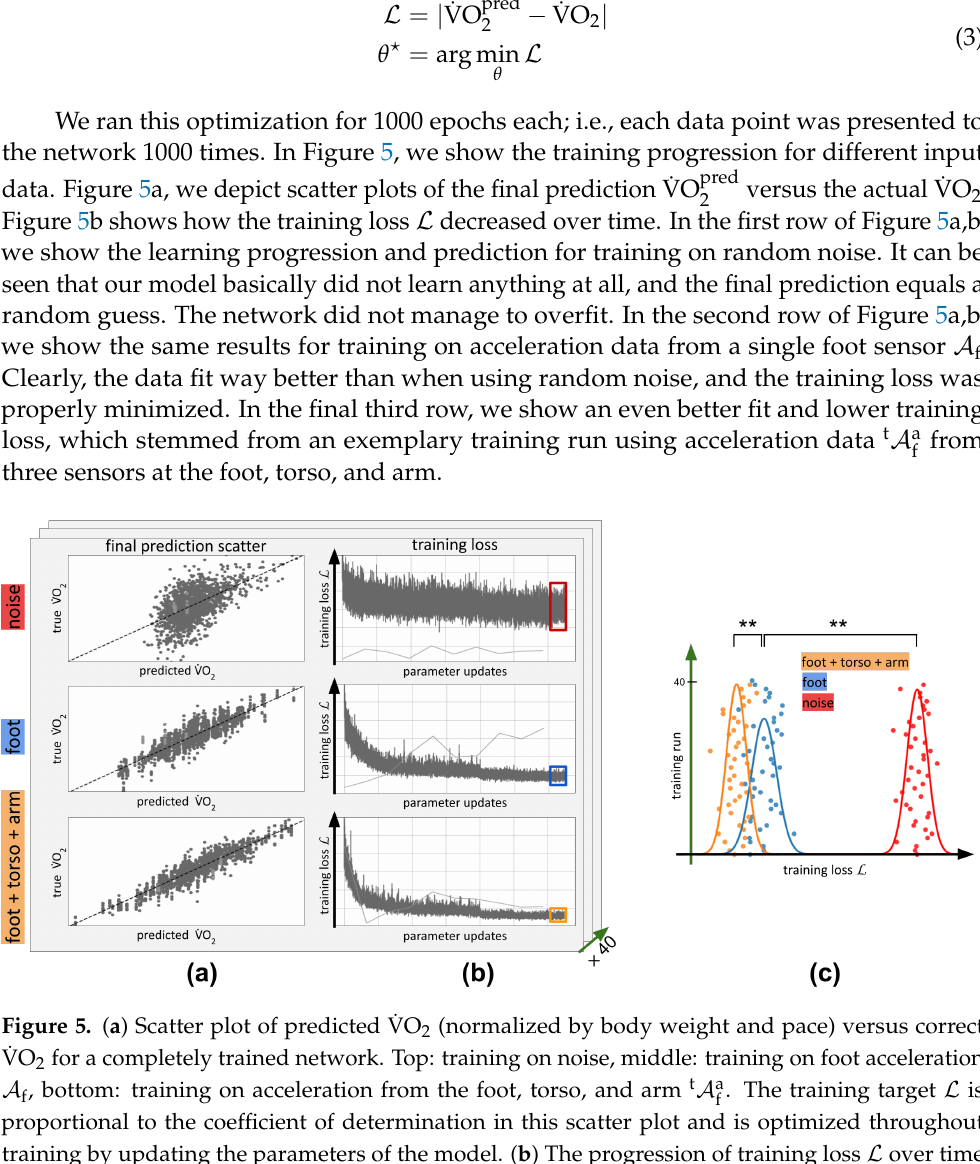
t A a . The training target L is f